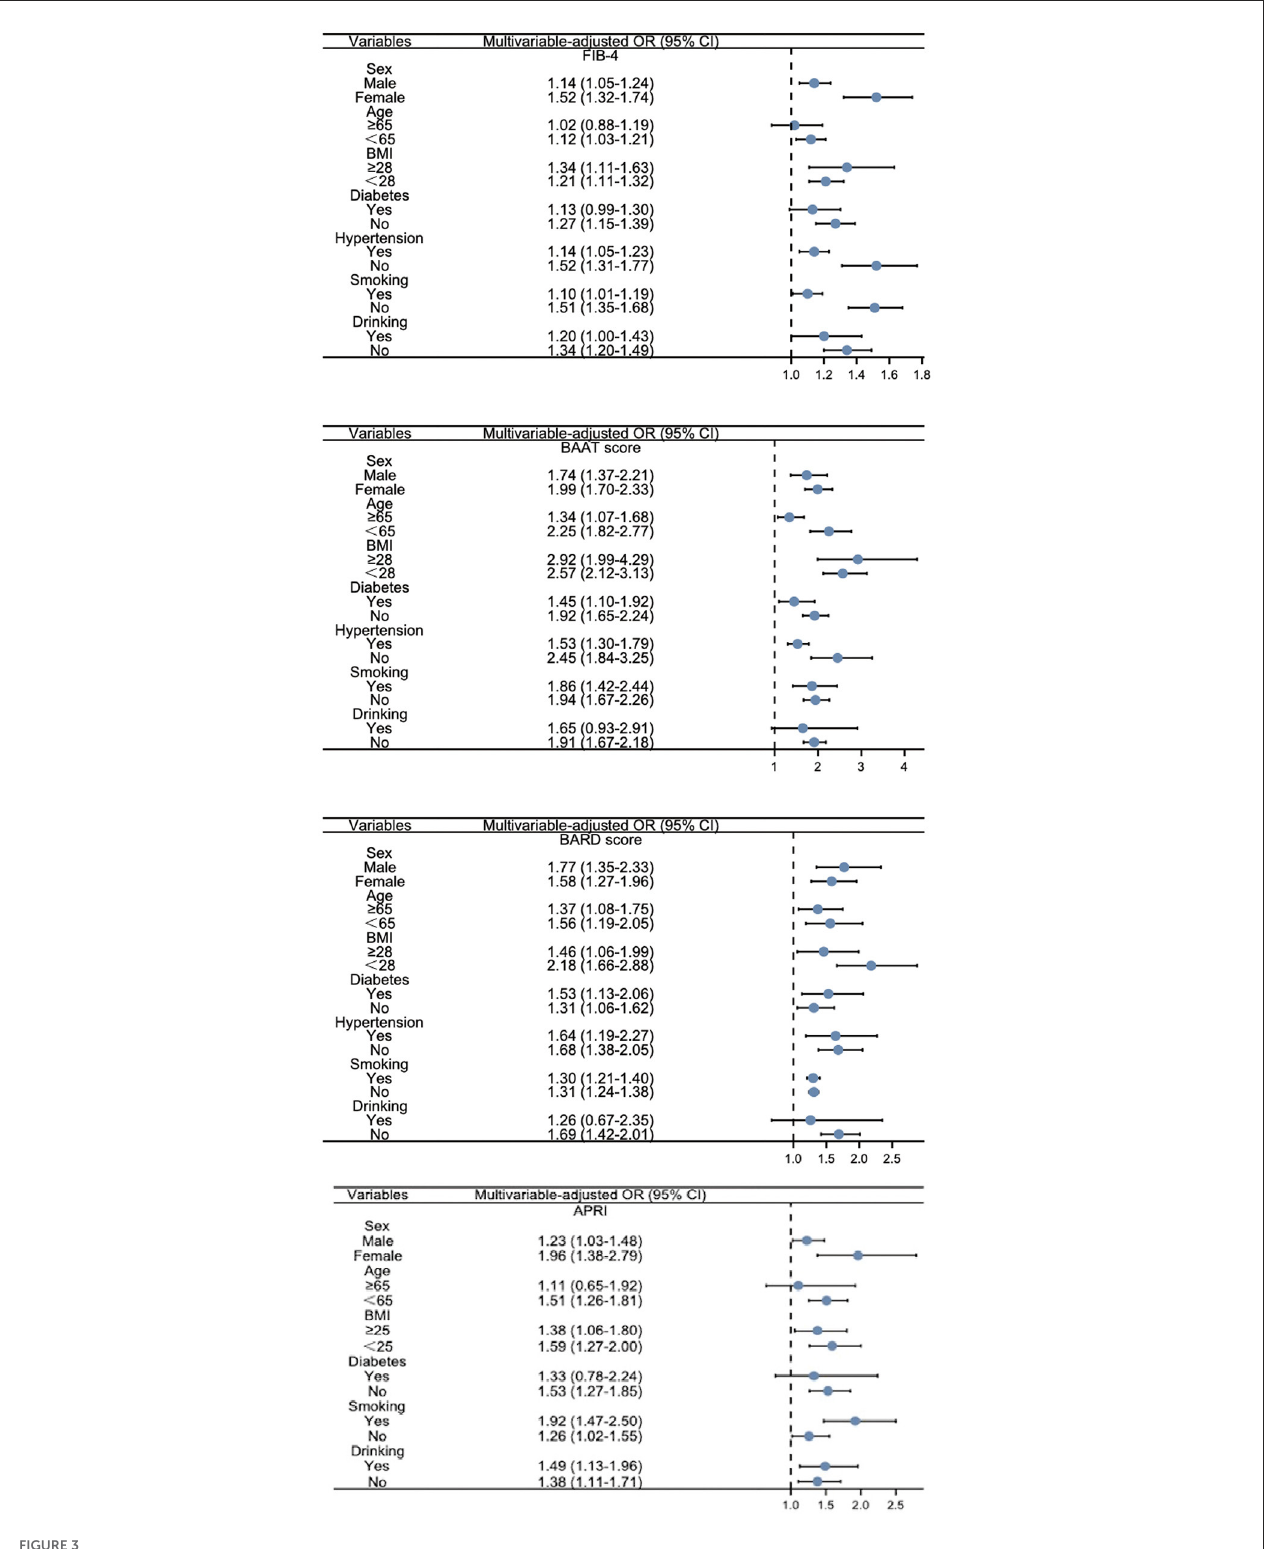
FIGURE3 Subgroup analysis of LFSs in relation to